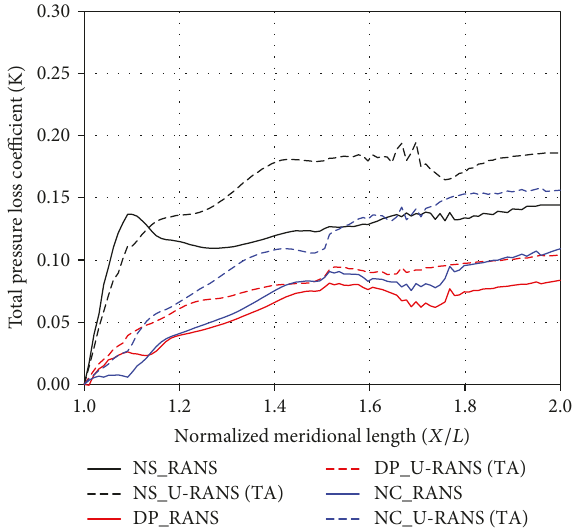
Figure 16: Blade loading on the di ff user vane at 95% span for the NS. Figure 17: Total pressure loss coe ffi cient distribution in the vaned